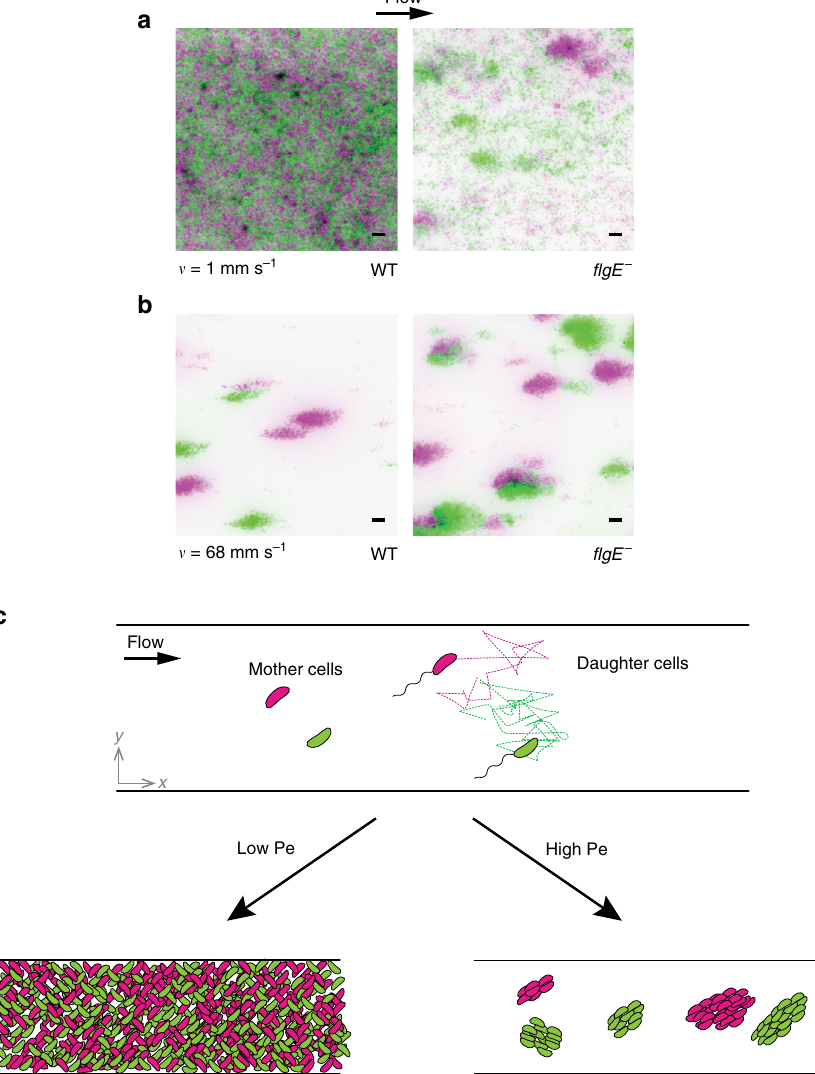
Fig. 4 Impact of motility on the spatial structure of cell lineages. Fluorescence microscopy images of wild-type (WT) or fl agellum-less ( fl gE − ) C. crescentus after 24 h of growth in a microchannel under low (1 mm s − 1 ) or high (68 mm s − 1 ) fl ow. Two populations at equal density, expressing either mKate or Venus fl uorescent proteins, were initially loaded in microchannels. a At low fl ow, the colonization pattern of fl gE − shows lower surface coverage and larger cluster size than WT. This qualitatively recapitulates the results observed in stronger fl ow for WT, indicating that fl agellum-powered swimming motility contributes to clonal dispersion. b Under strong fl ows, when advective transport dominates over bacterial swimming, WT and fl gE − cells form similar bio fi lm patterns. Green: C. crescentus mKate. Magenta: C. crescentus Venus. Scale bars: 10 μ m. c Within the framework of our model, the ratio of diffusive to advective transport timescales in fl uences heterogeneity of clonal distributions in space. Indeed, Brownian-like single cell trajectories generate dispersion of bacterial clones across the channel surface at low Pe. Strong fl ows (large Pe) mitigate this effect by increasing